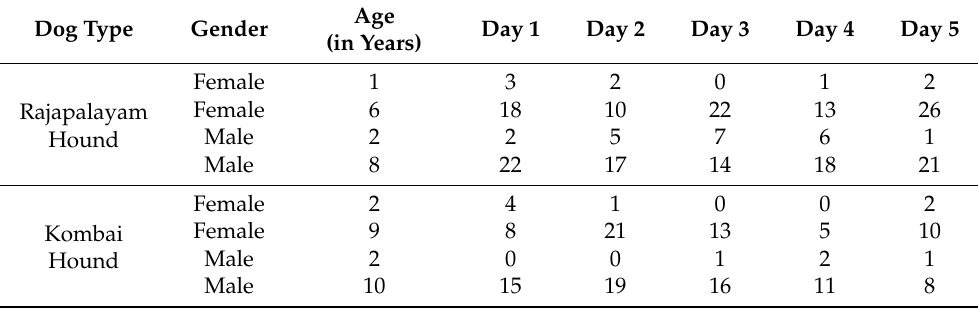
Table A1. Dog Sounds Recorded While the Stranger is Walking.